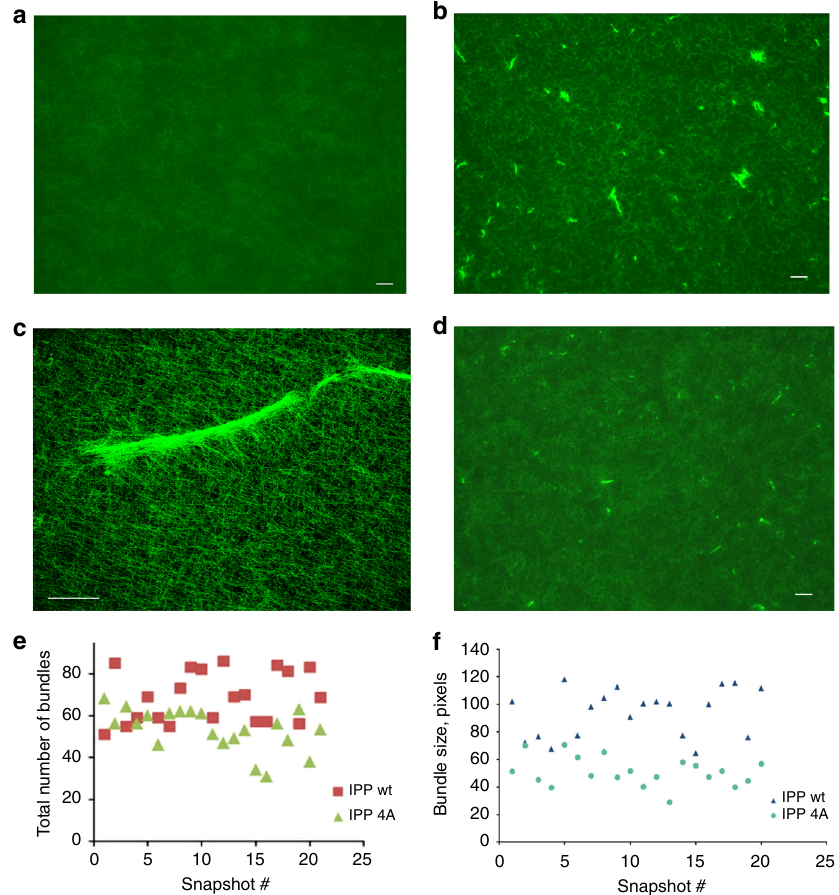
Fig. 4 IPP triggers F-actin bundle formation. a Selected microscopic image showing the uniform F-actin fi lament network in the presence of the buffer alone. b Selected microscopic image showing F-actin bundles in the presence of IPP. c A high resolution image of IPP-induced F-actin bundle detected by confocal microscopy. d Selected image showing that IPP-4A mutations led to drastically reduced F-actin bundle formation as compared with ( b ). e and f . Quantitative comparison on the number ( e ) and size ( f ) of the F-actin bundles induced by IPP and IPP-4A, respectively. Bar = 100 μ m except in ( c ) where bar = 50 μ